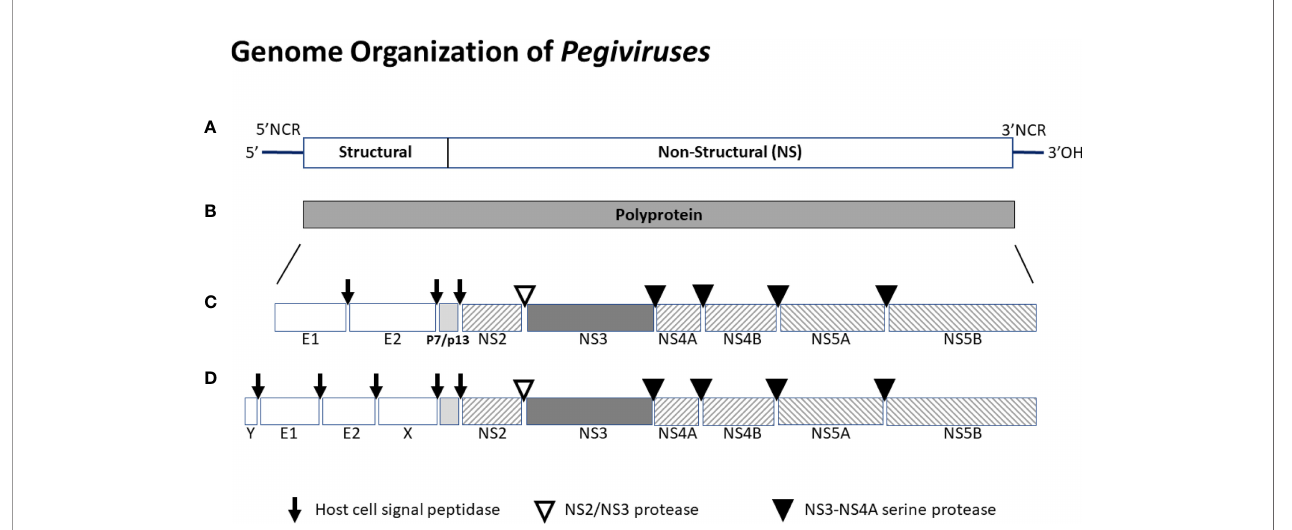
FIGURE 2 | Schematic of the genome organization of pegiviruses . Pegivirus genomes range from 8.9 to 11.3 kb, and those with longer genomes (e.g. HPgV-2) produce two additional structural proteins (X and Y). The genome (A) has a highly structured 5 ’ noncoding region (NCR) that contains an internal ribosomal entry site directing translation, and a 3 ’ NCR. The positive sense viral genome is translated and encodes a single polyprotein (B) that is co- and post-translationally cleaved into the fi nal viral proteins (C or D) . Structural proteins are cleaved by host cell signal peptidases. Nonstructural proteins NS2-NS3 are cleaved by the NS2-NS3 autoprotease while NS3 to NS5 proteins are cleaved by the NS3-NS4A protease complex. All pegiviruses have two structural proteins (envelope glycoproteins E1 and E2), and those with longer genomes have two additional predicted structural proteins - a basic protein of unknown function upstream of E1 (Y) and some pegiviruses contain a predicted glycoprotein downstream of E2 (X). The RNA dependent, RNA polymerase resides in NS5B. The human pegivirus (HPgV-1) genome is approximately 9.4 kb and the fi nal protein organization is shown in the middle panel (B)